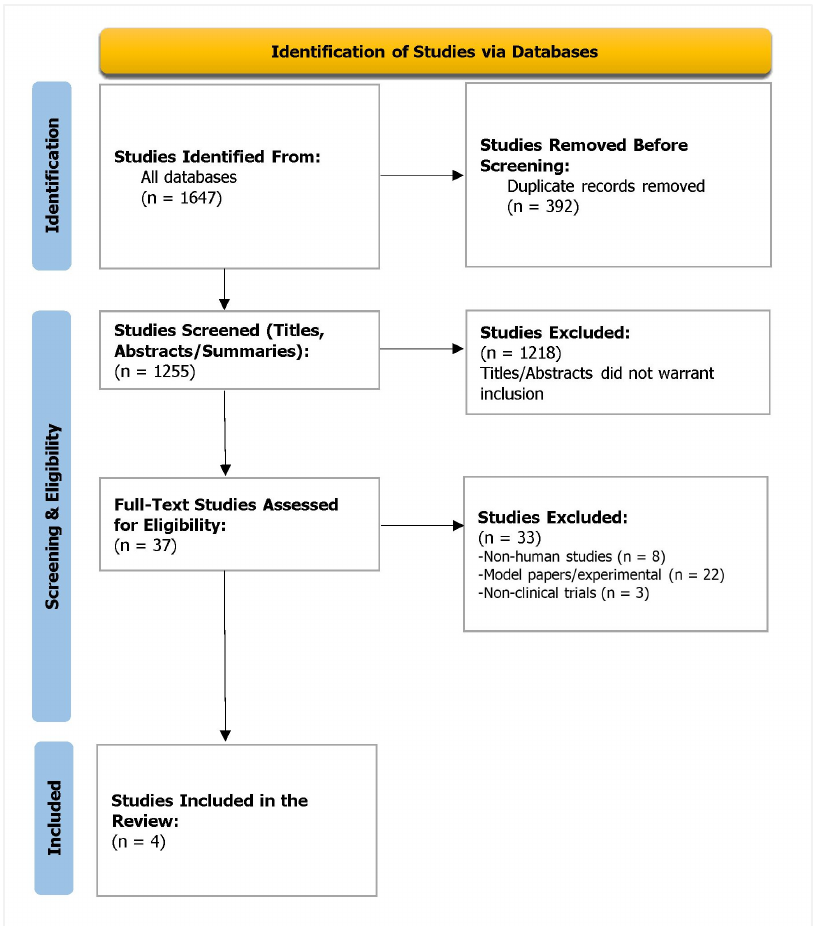
Figure 1. PRISMA flowchart depicting the study selection process.